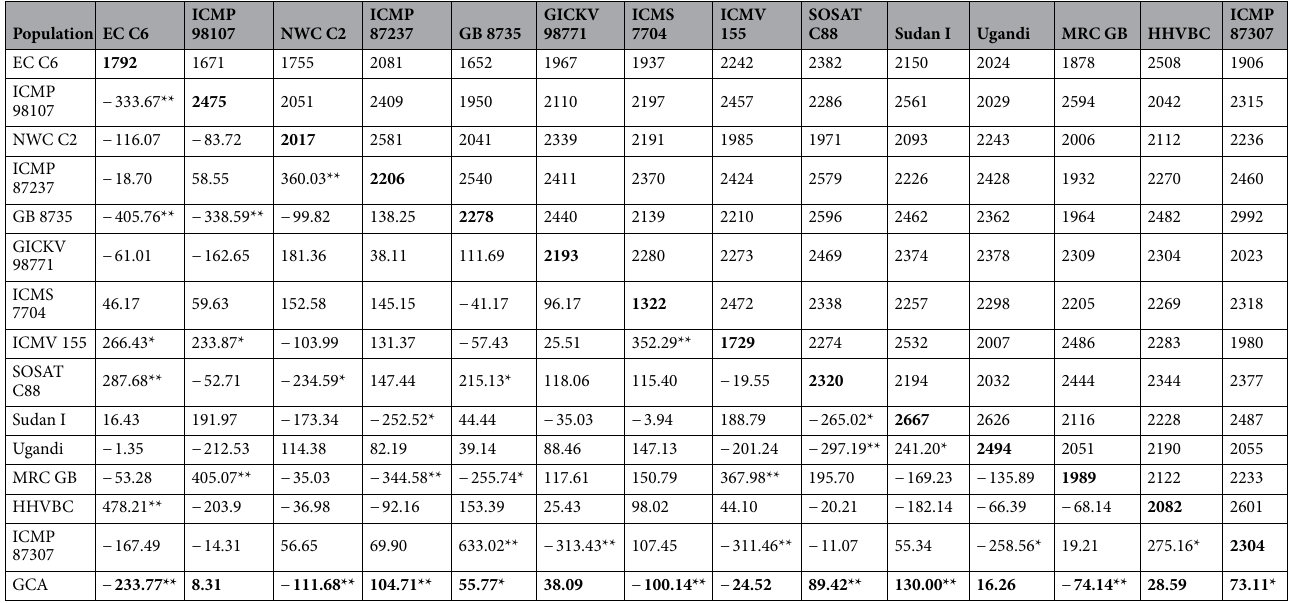
Table 5. Combining ability effects (SCA-below diagonal and GCA-bottom row), parental populations’ grain yield (in bold and on diagonal in kg ha −1 ) and population hybrids’ grain yield (above diagonal in kg ha −1 ) across three locations. *, **Significant at 0.05 and 0.01 levels of probability,